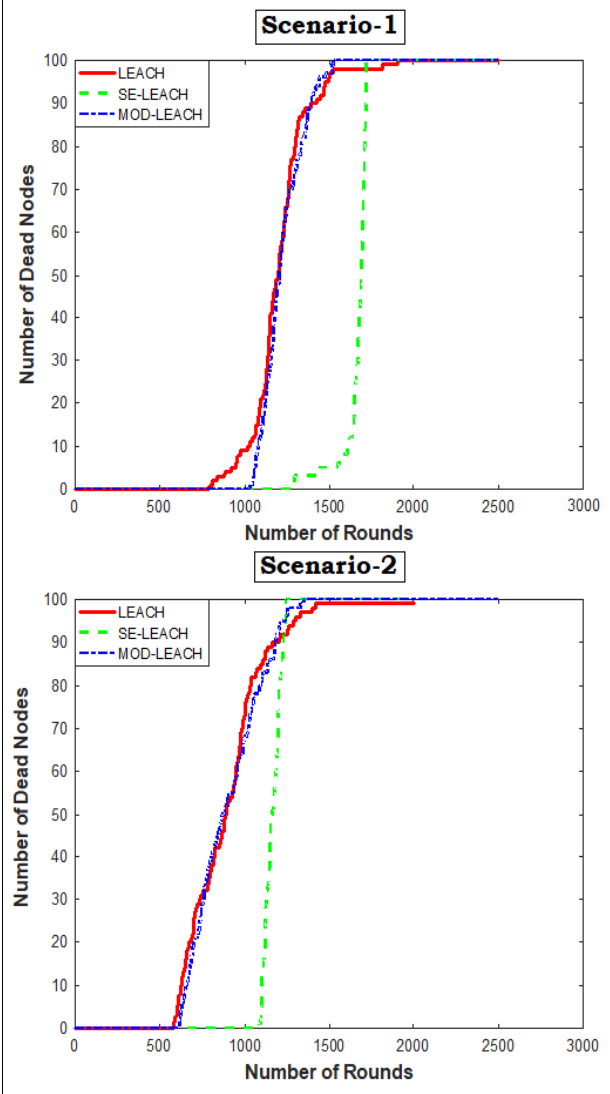
Figure 3. Dead Nodes per round